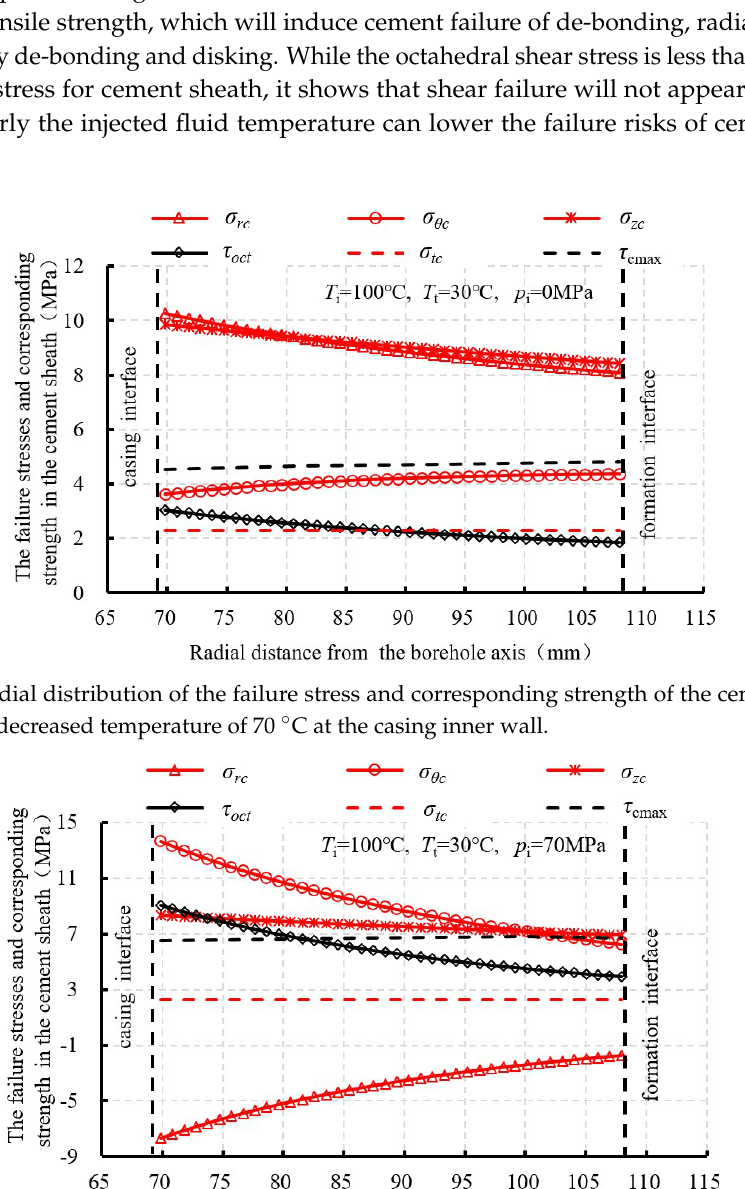
Figure 14. Radial distribution of the failure stress and corresponding strength of the cement sheath under an increased casing pressure p i of 70 MPa and a decreased temperature of 70 °C at the casing inner wall.